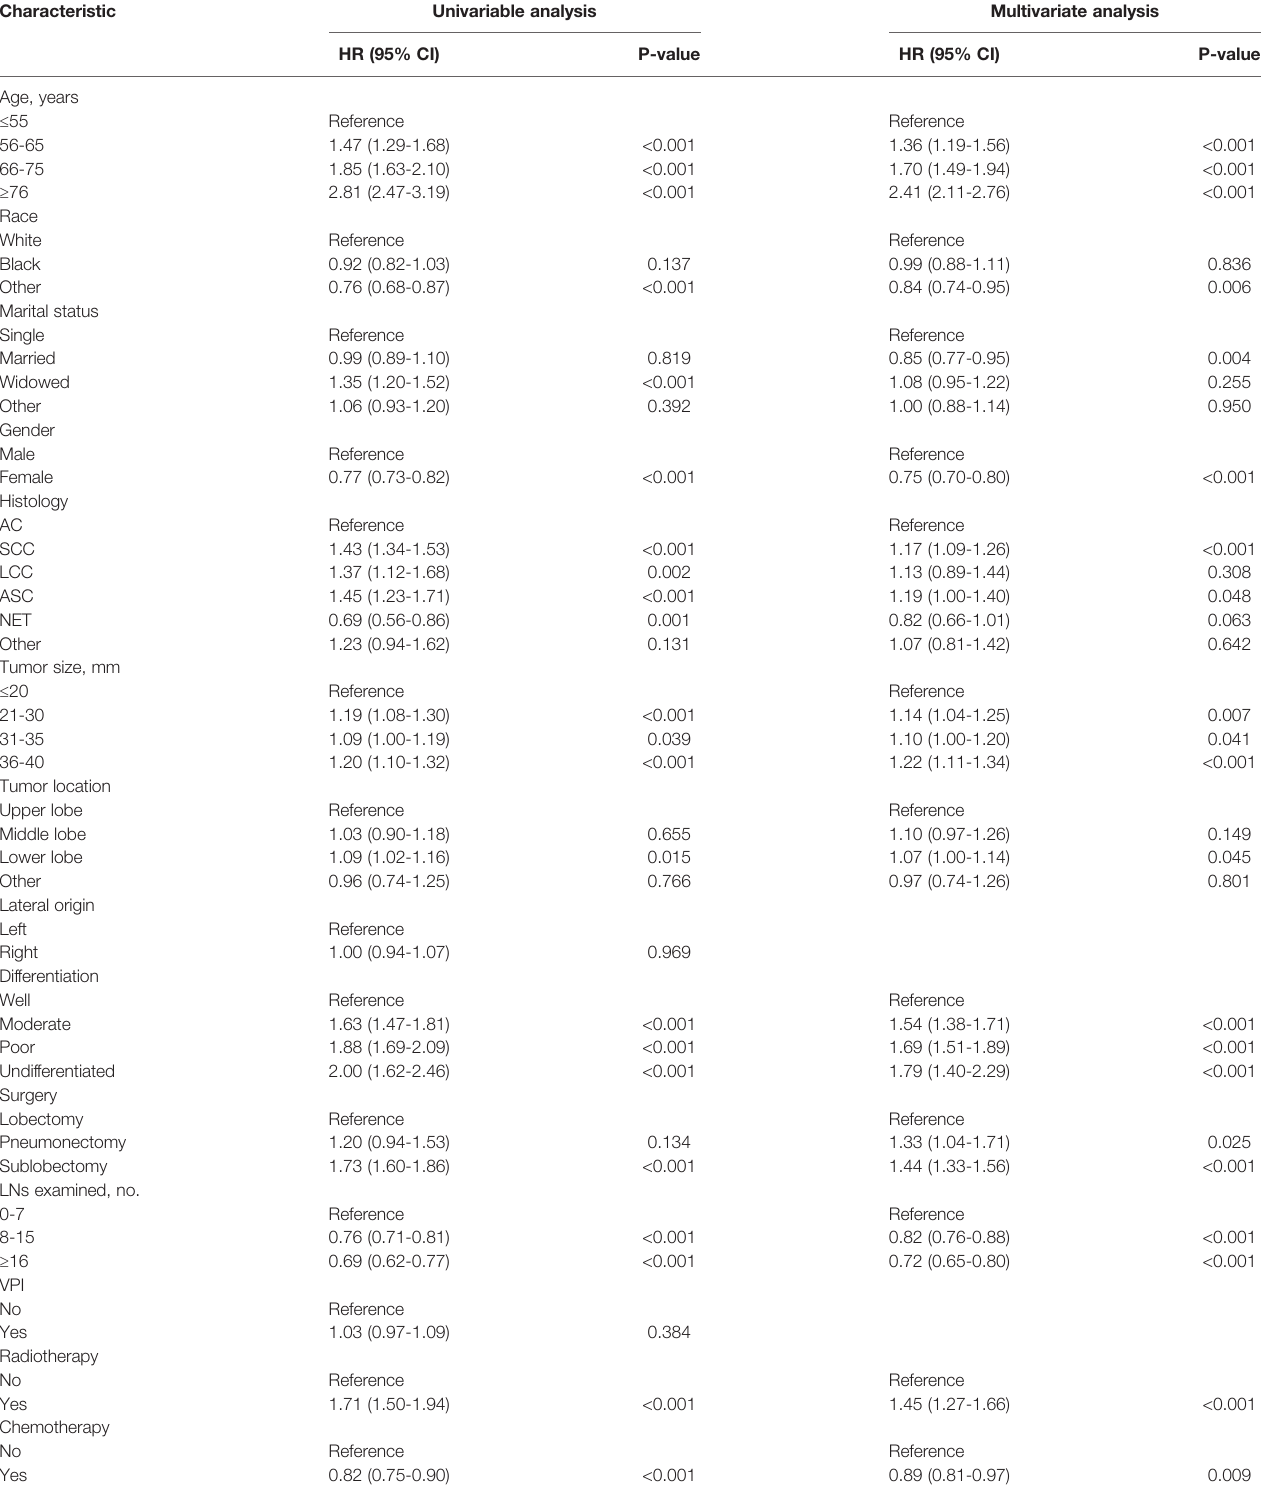
TABLE 2 | Univariate and multivariate analyses of overall survival in all resected stage IB NSCLC